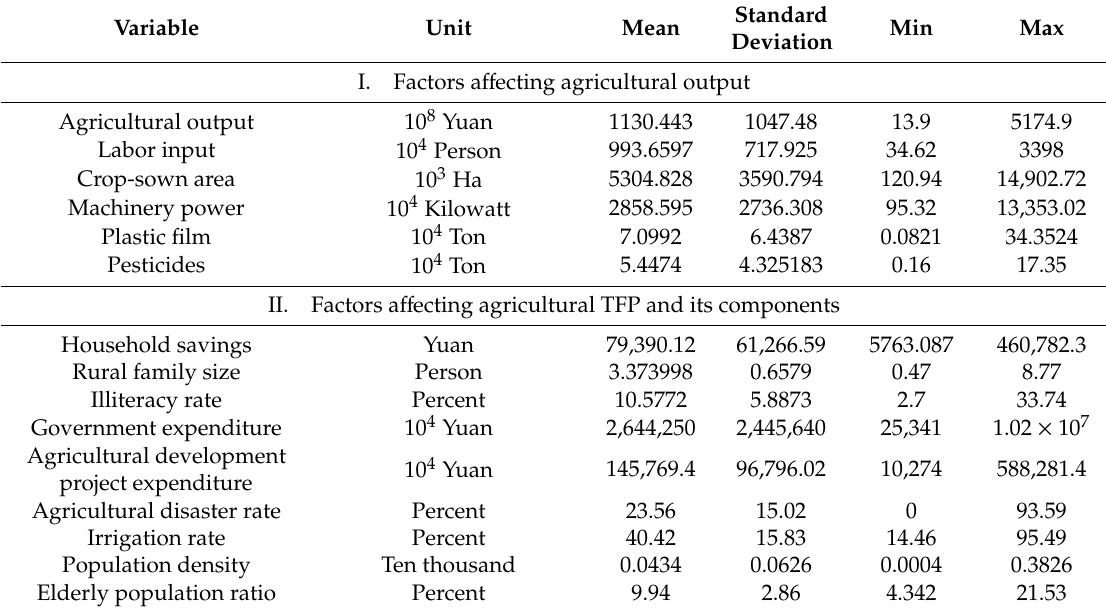
Table 1. Descriptive